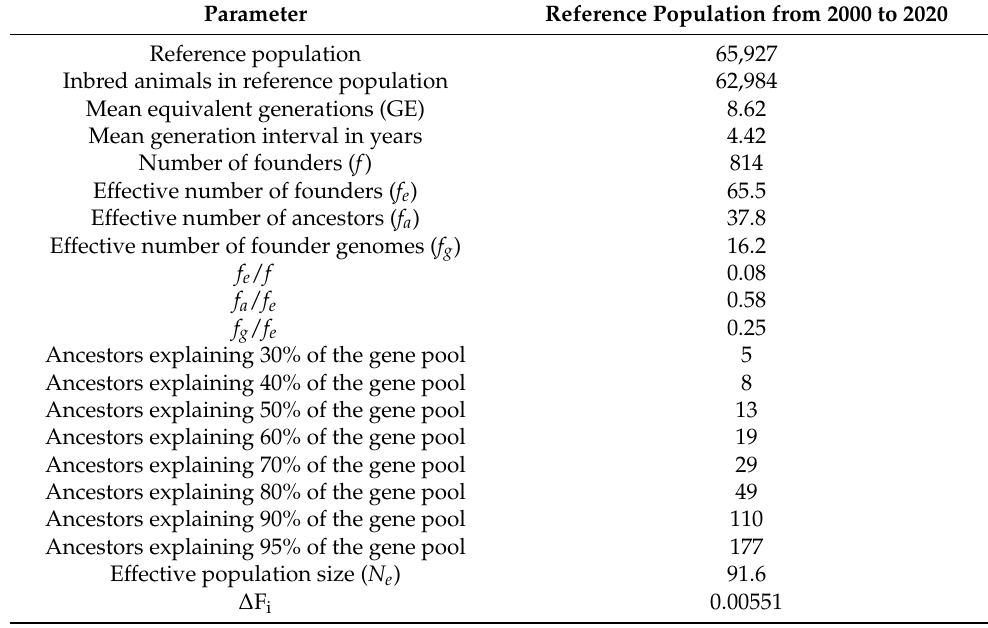
Table 1. Pedigree analysis for measures of genetic diversity for Deutsch Drahthaar dogs born from 2000 to